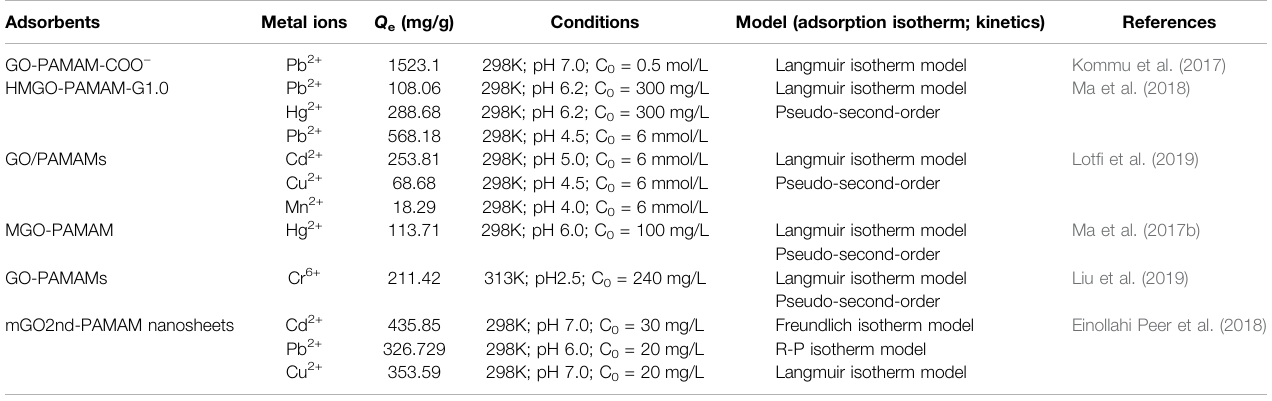
TABLE 1 | Heavy metal ions adsorbed by polyamide amine/graphene oxide composites. Adsorbents